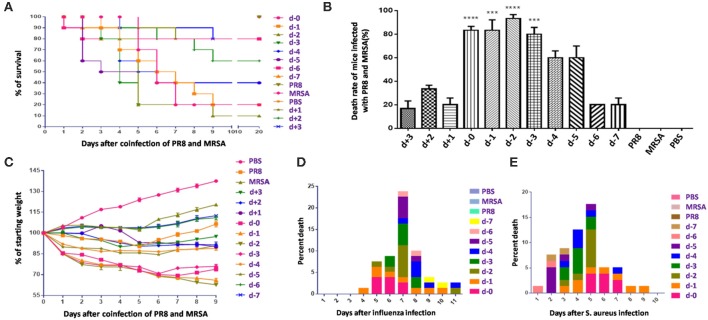
Mortality in mice coinfected with influenza virus and methicillin-resistant S. aureus differed with the sequence and timing of infection. (A) Survival rates in mice coinfected with influenza virus (PR8) and methicillin-resistant S. aureus (MRSA) were infection sequence- and time-dependent. In mice coinfected with equivalent doses, those first infected with PR8 followed by MRSA had higher mortality rates than those first infected with MRSA. (B) Mortality of mice coinfected using various infection sequences and timings (***p < 0.001; ****p < 0.0001, n = 6). (C) Body weight changes in coinfected mice. (D) The cumulative mortality rate after coinfection of mice in groups d to d-7 with PR8 shows that the coinfected mice had the highest mortality rate on the seventh day post-PR8 infection. (E) The cumulative mortality rate after groups d to d-7 were coinfected with MRSA; mortality rates rose in the first 5 days after MRSA infection.